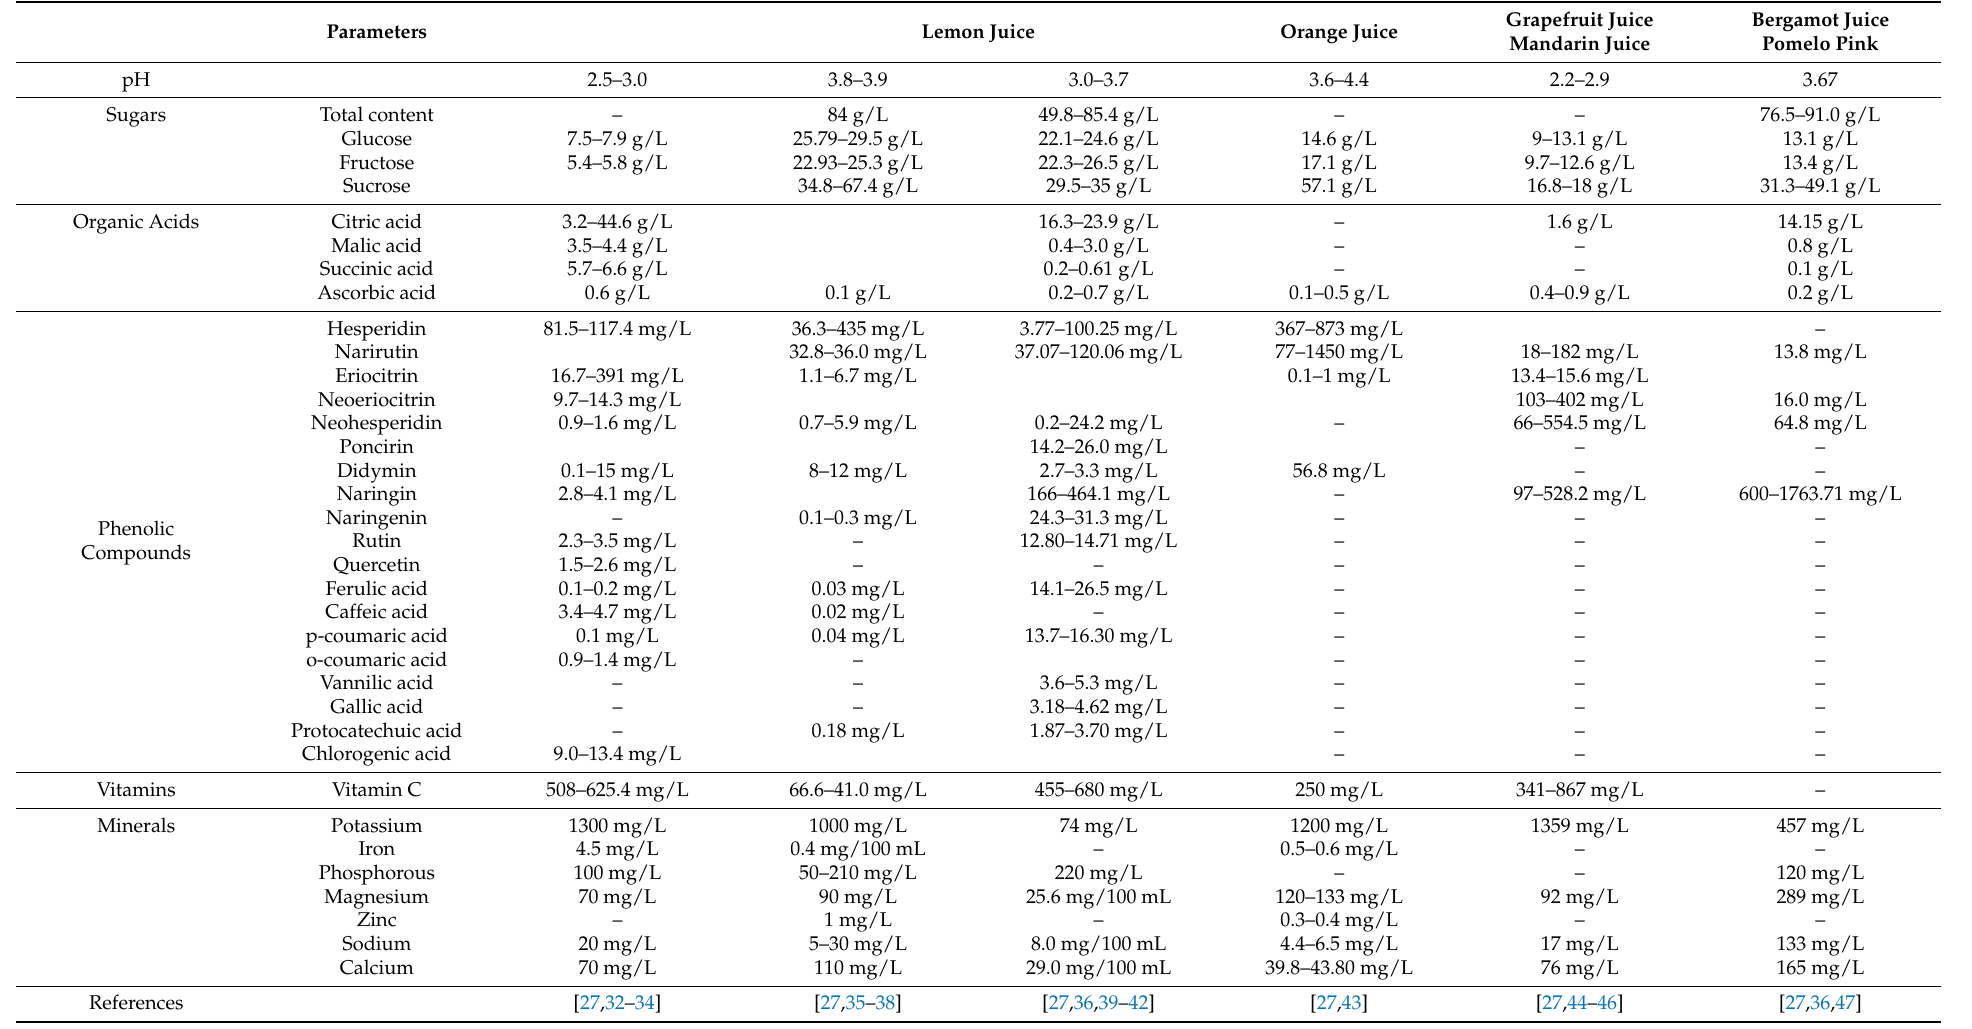
Table 1. Main nutritional and bioactivity parameters of different citrus juices: lemon, orange, grapefruit, mandarins, bergamot, and pomelo.